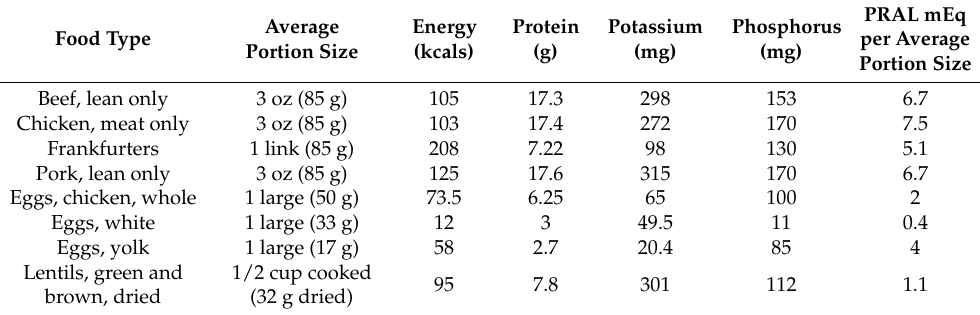
Table 3. The potential renal acid load (PRAL) of food (per average portion size)